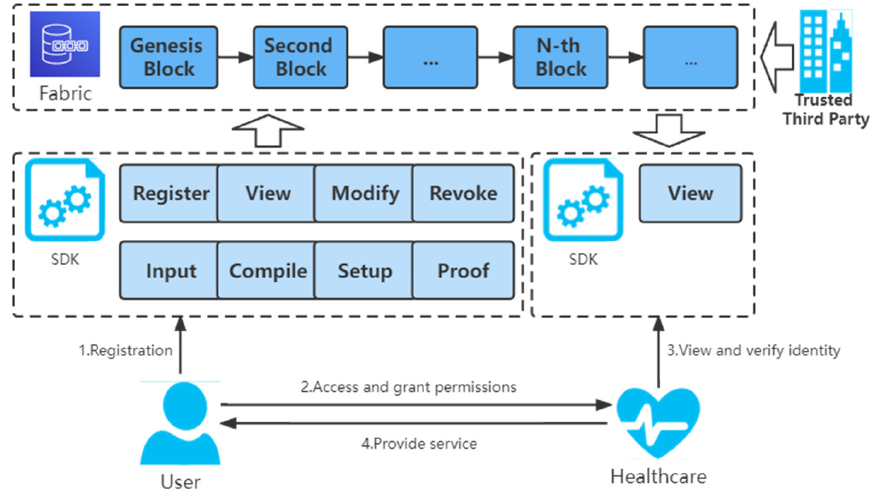
Figure 3. The improved identity model.